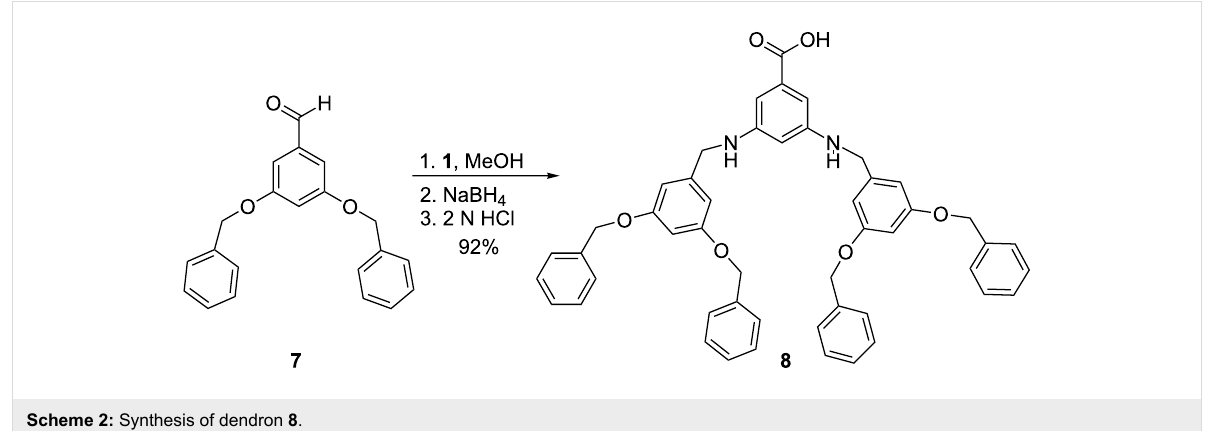
Scheme 2: Synthesis of dendron 8